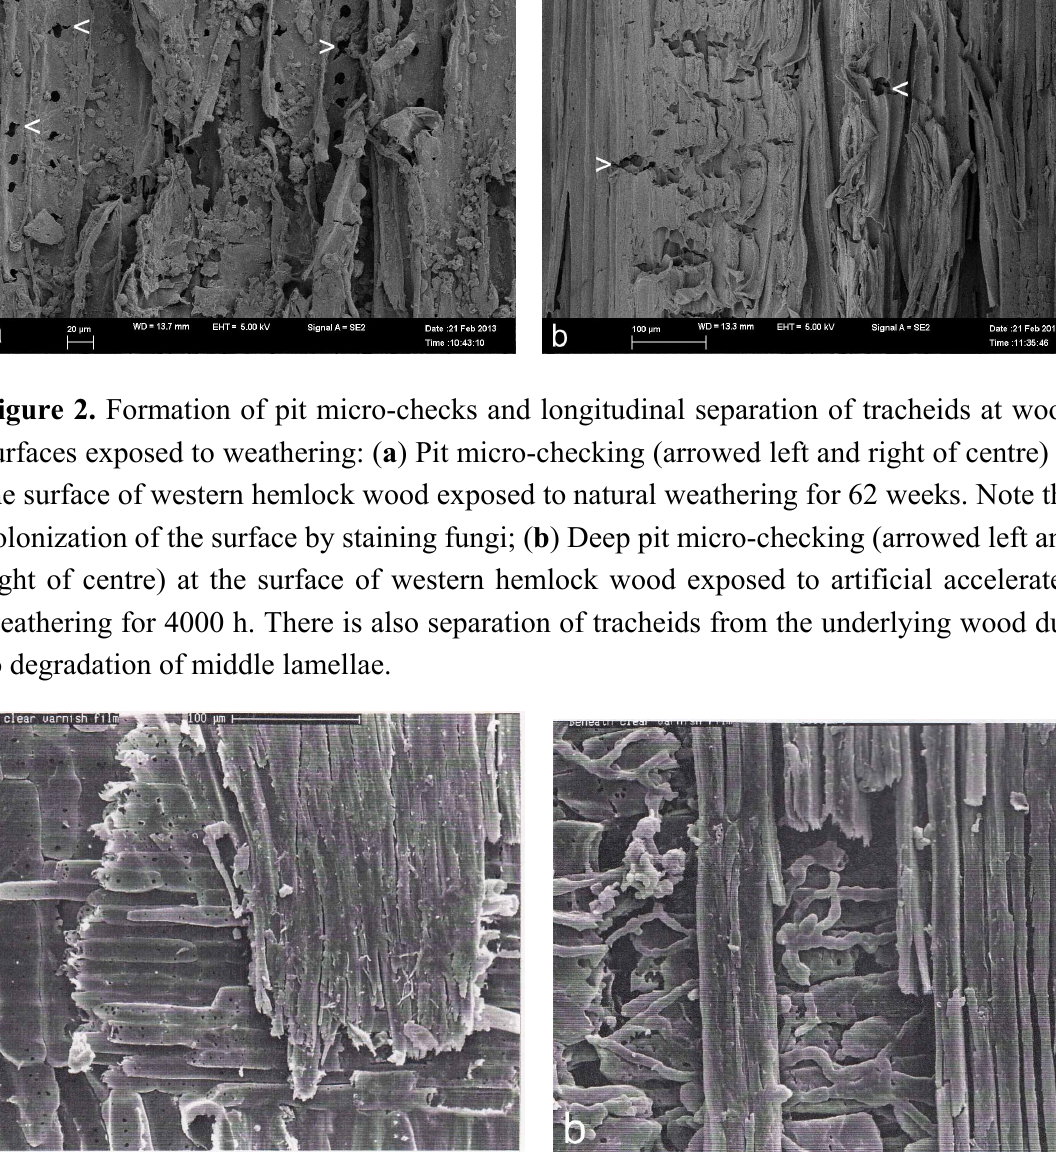
Figure 3. Surface of kempas wood beneath a clear coating exposed outdoors for 18 months: ( a ) Area beneath part of the coating that adhered well to the wood; ( b ) Area beneath part of the coating that adhered poorly to the wood. Note the colonization of the wood surface by staining